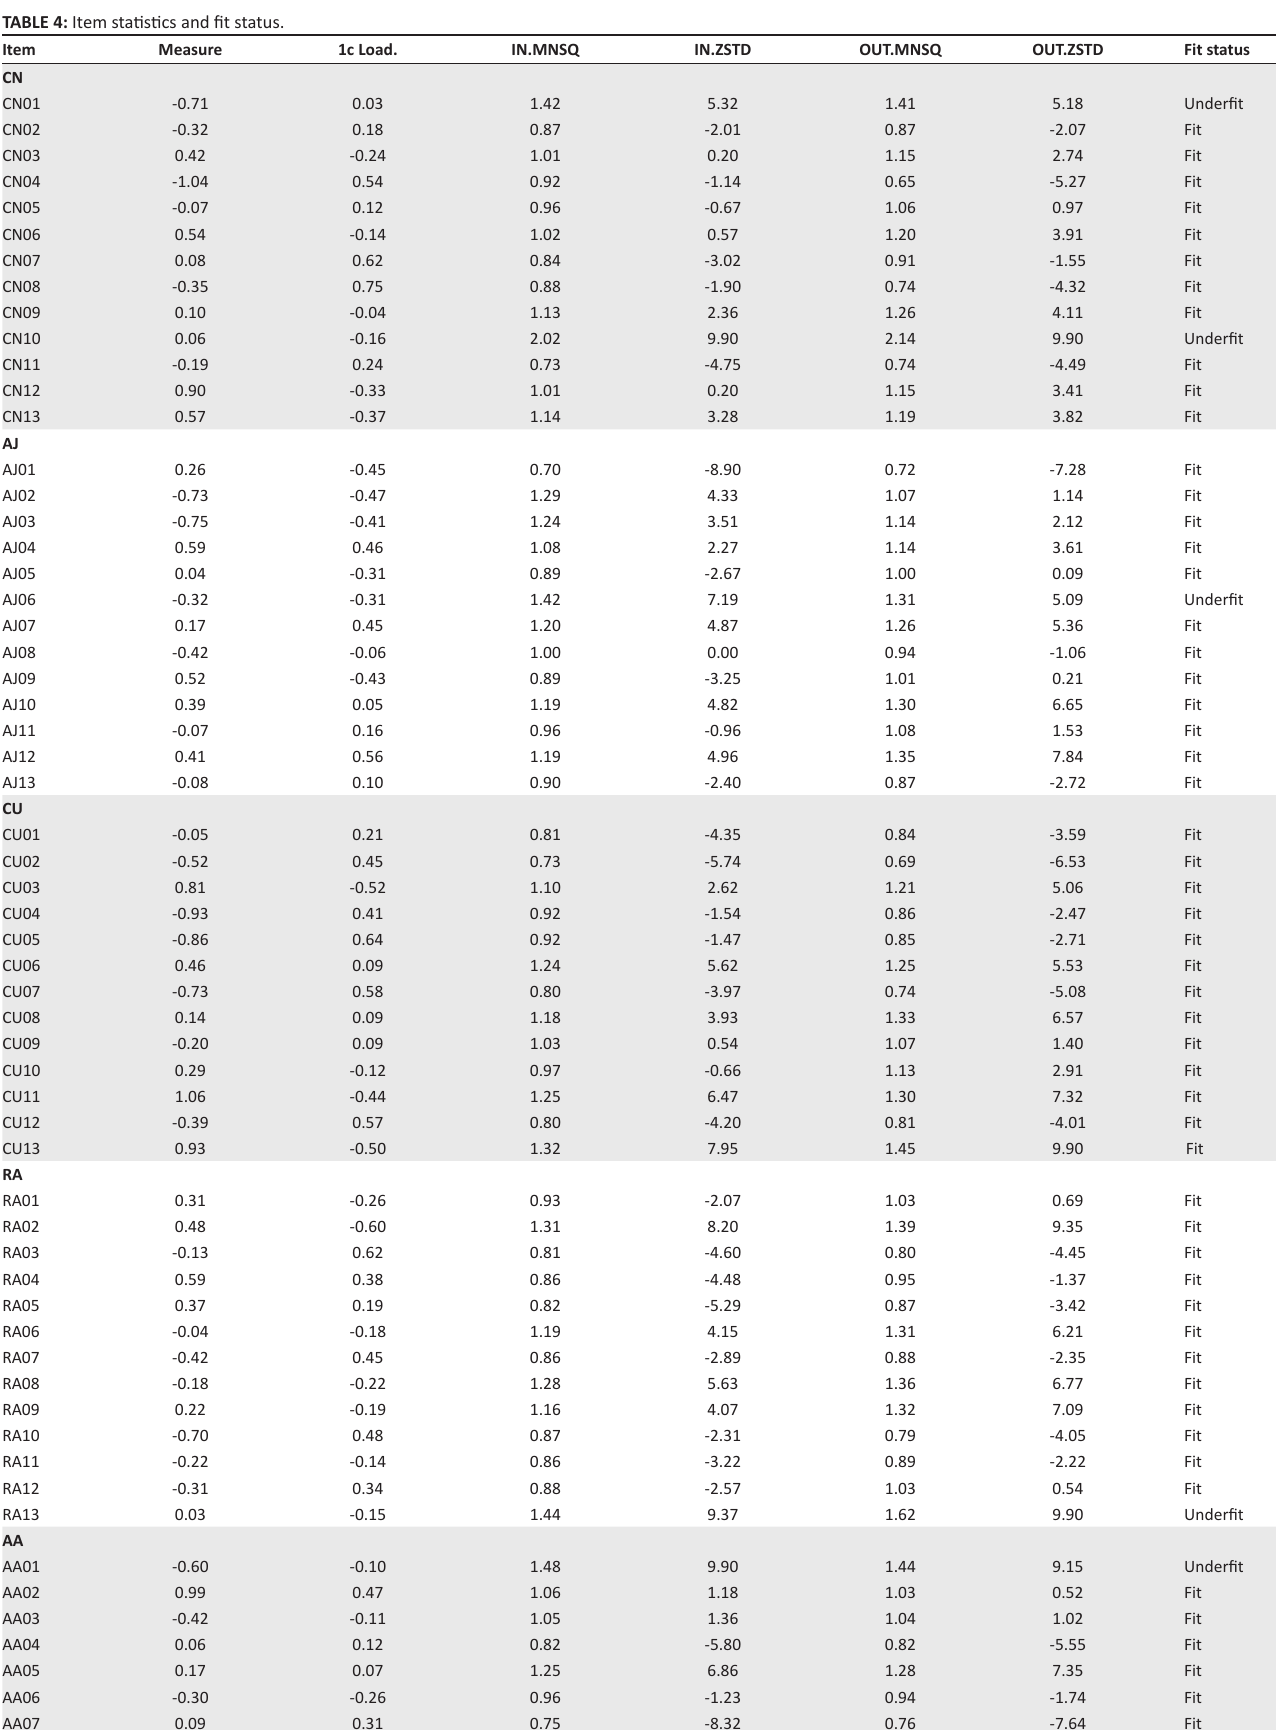
TABLE 4: Item statistics and fit